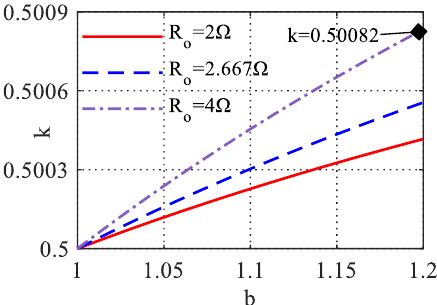
Figure 6. Solutions of k for different values of b at different output resistances.